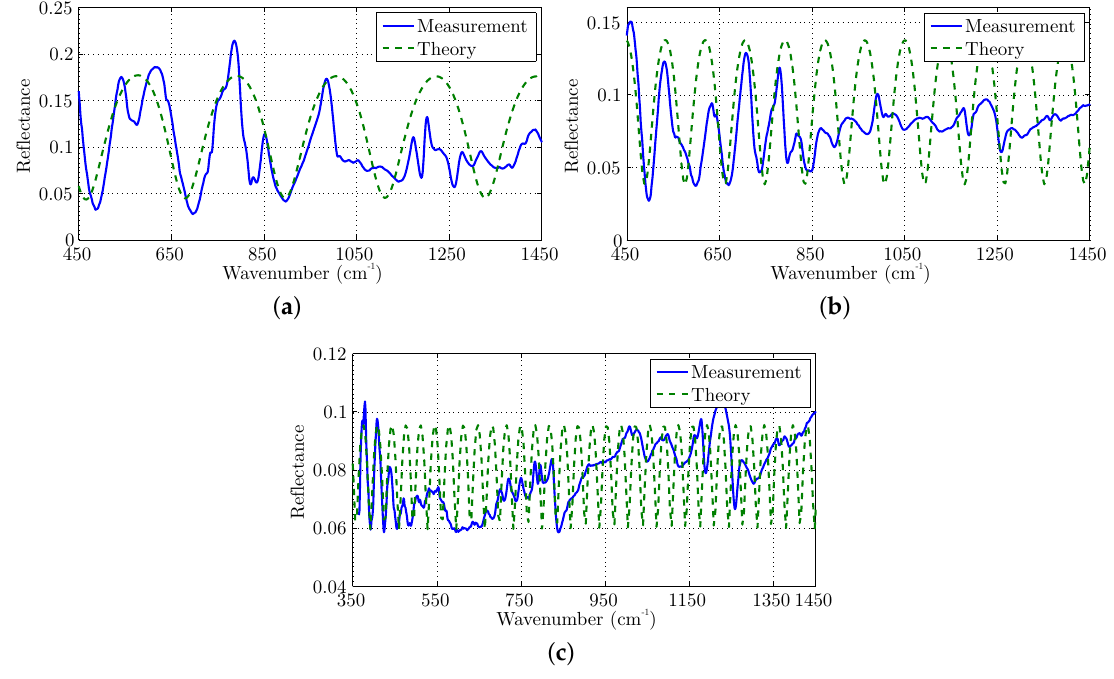
Figure 7. Comparison of the proposed transmission line model (theory) to the measured Certified Reference Materials (measurement) with a thickness of ( a ) 15.55 µ m, ( b ) 39.71 µ m, and ( c ) 98.91 µ m.